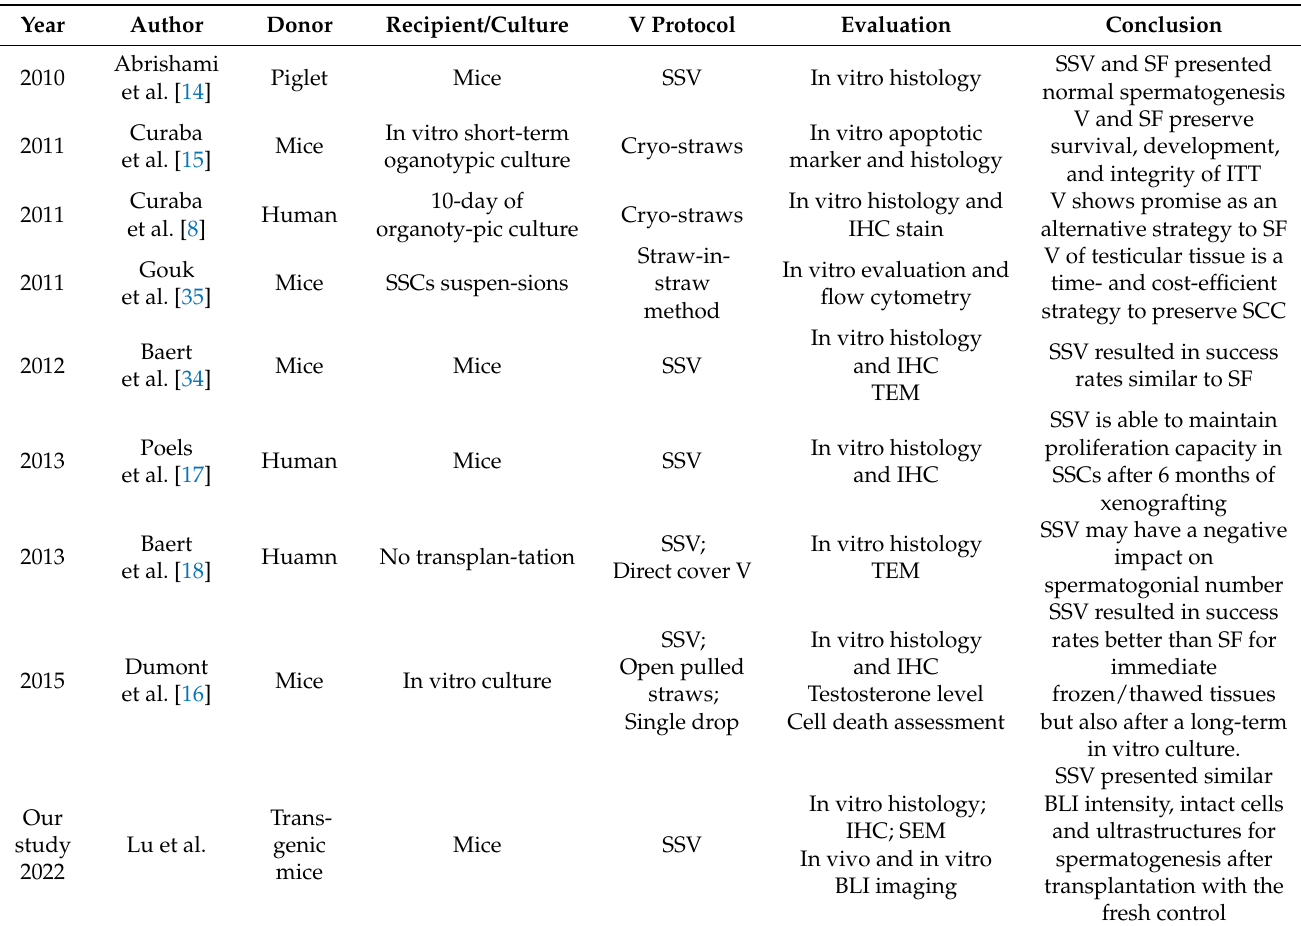
Table 1. Summary of eight studies compared vitrification (V) with slow freezing (SF) for ITT